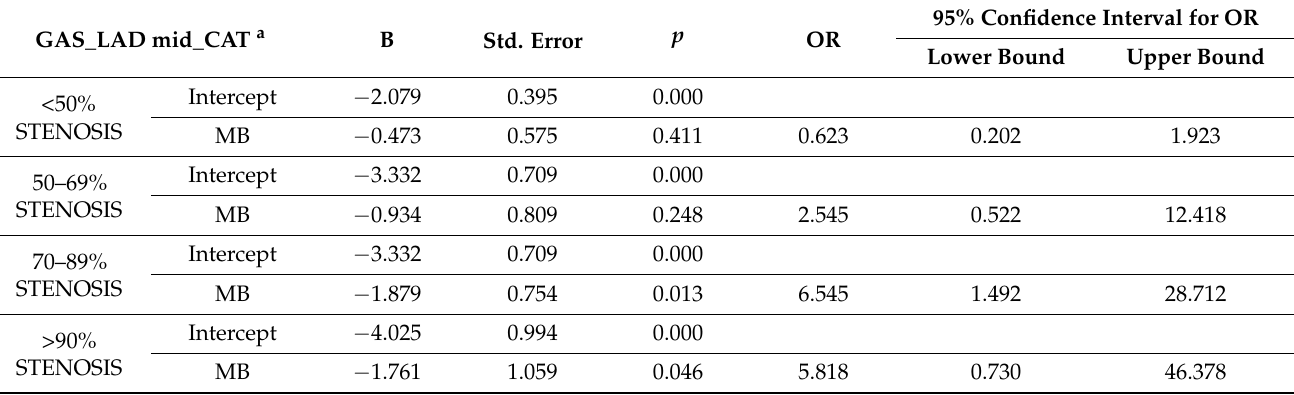
Table 6. Regression model for the probability of atherosclerotic stenosis on the mid-segment of left anterior descending artery in the presence of myocardial bridges.